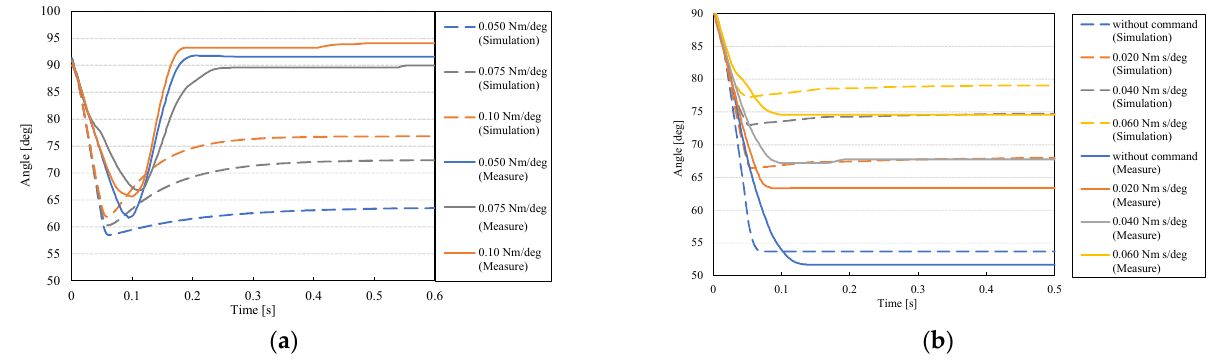
Figure 21. Simulation and measurement results of impact force experiment. ( a ) Results of angle (joint stiffness). ( b ) Results of angle (joint viscosity).